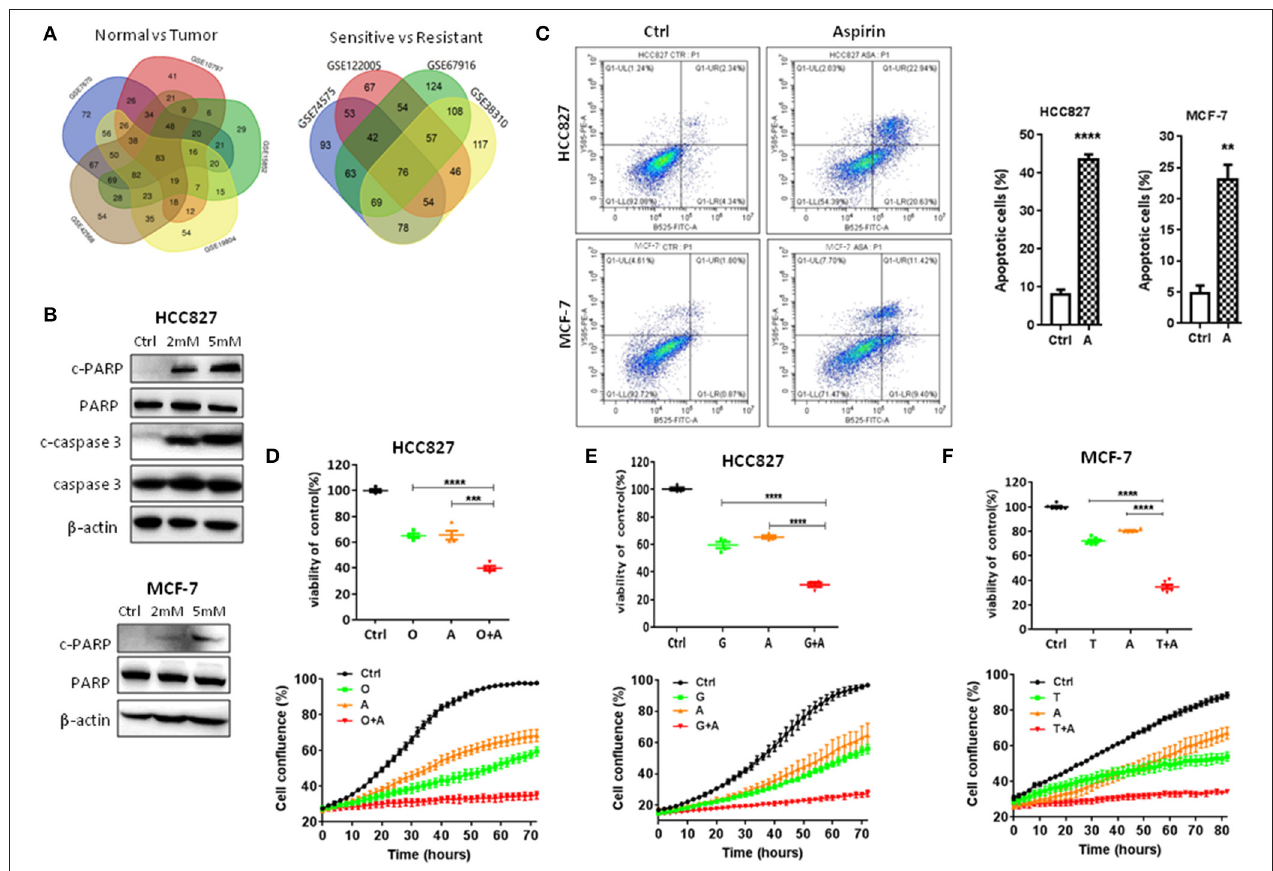
FIGURE 1 | Aspirin inhibited proliferation and promoted apoptosis of lung and breast cancer cells. (A) The Venn diagram represents the number of drugs using five data sets (GSE19804, GSE42568, GSE15852, GSE10797, and GSE7670) or four data sets (GSE74575, GSE38310, GSE67916, GSE122005) to query the CMap. (B) Western blot analysis of cleaved-caspase 3 (c-caspase 3), caspase 3, cleaved-PARP (c-PARP), and PARP in HCC827 and MCF-7 cells treated with indicated concentrations of aspirin for 72h. β -actin was used as loading control. (C) Flow cytometry analysis of apoptosis of HCC827 treated with 2mM aspirin and of MCF-7 cells treated with 2mM aspirin for 72h (left panels). Quantitative analysis of apoptotic cells identified by flow cytometry (right panels). Data were obtained from three independent experiments. (D–F) Cell viability by CCK8 assay (upper panels) and IncuCyte growth curves (lower panels) of indicated cells treated with 10nM osimertinib (O), 10nM gefitinib (G), 2mM aspirin (A), 2 µ M tamoxifen (T), O + A, G + A, or T + A for 72h as indicated. The data are presented as the means ± SEM. Student’s t -test was used. * P < 0.05; ** P < 0.01; *** P < 0.001; **** P <